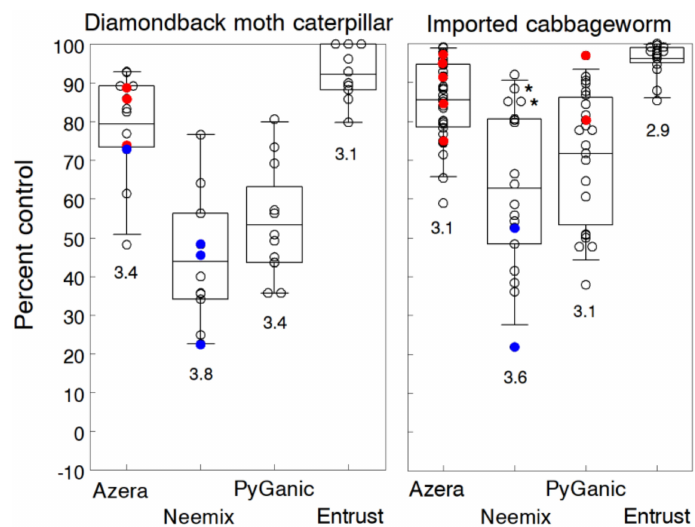
Figure 10. Percent control of cabbageworms with weekly applications of Azera, Neemix, PyGanic and Entrust relative to the untreated control. Mean data are given for diamondback moth caterpillar and imported cabbageworm compiled over 9 cabbage trials, 5 collard trials and 5 broccoli trials. Box-whisker plots show the 25% and 75% percentile range of percent control data and the horizontal line in each box is the overall mean control e ffi cacy. Number below each plot indicates the average number of weekly applications. Application rates of Azera, Neemix, PyGanic and Entrust were 2.34 L / h, 1169 mL / h, 2.34 L / h and 71.2 g a.i. / h respectively, except for individual trial data in blue and red indicating lower and higher rates, respectively. Azera and Entrust provided significantly higher control of both cabbageworms than Neemix and